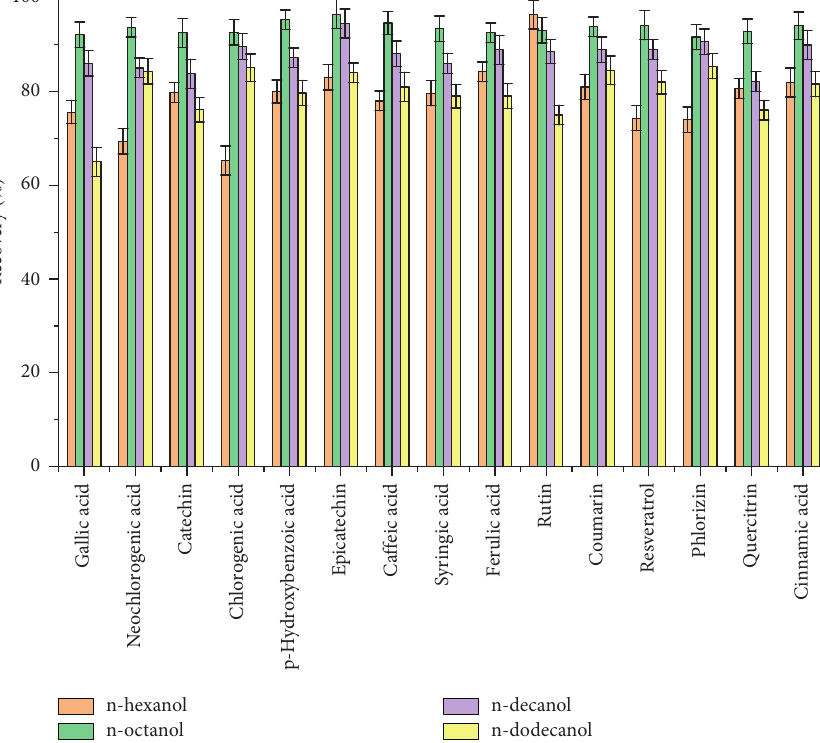
Figure 3: Effect of extraction solvent type on the ER% in